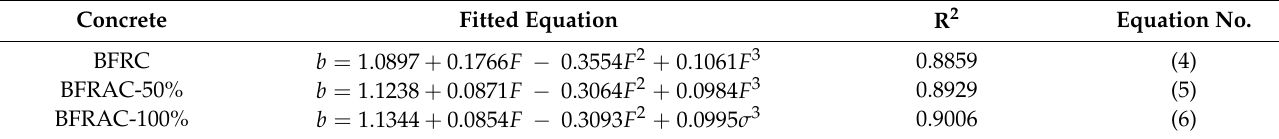
Table 7. The fitting equation between b and F.